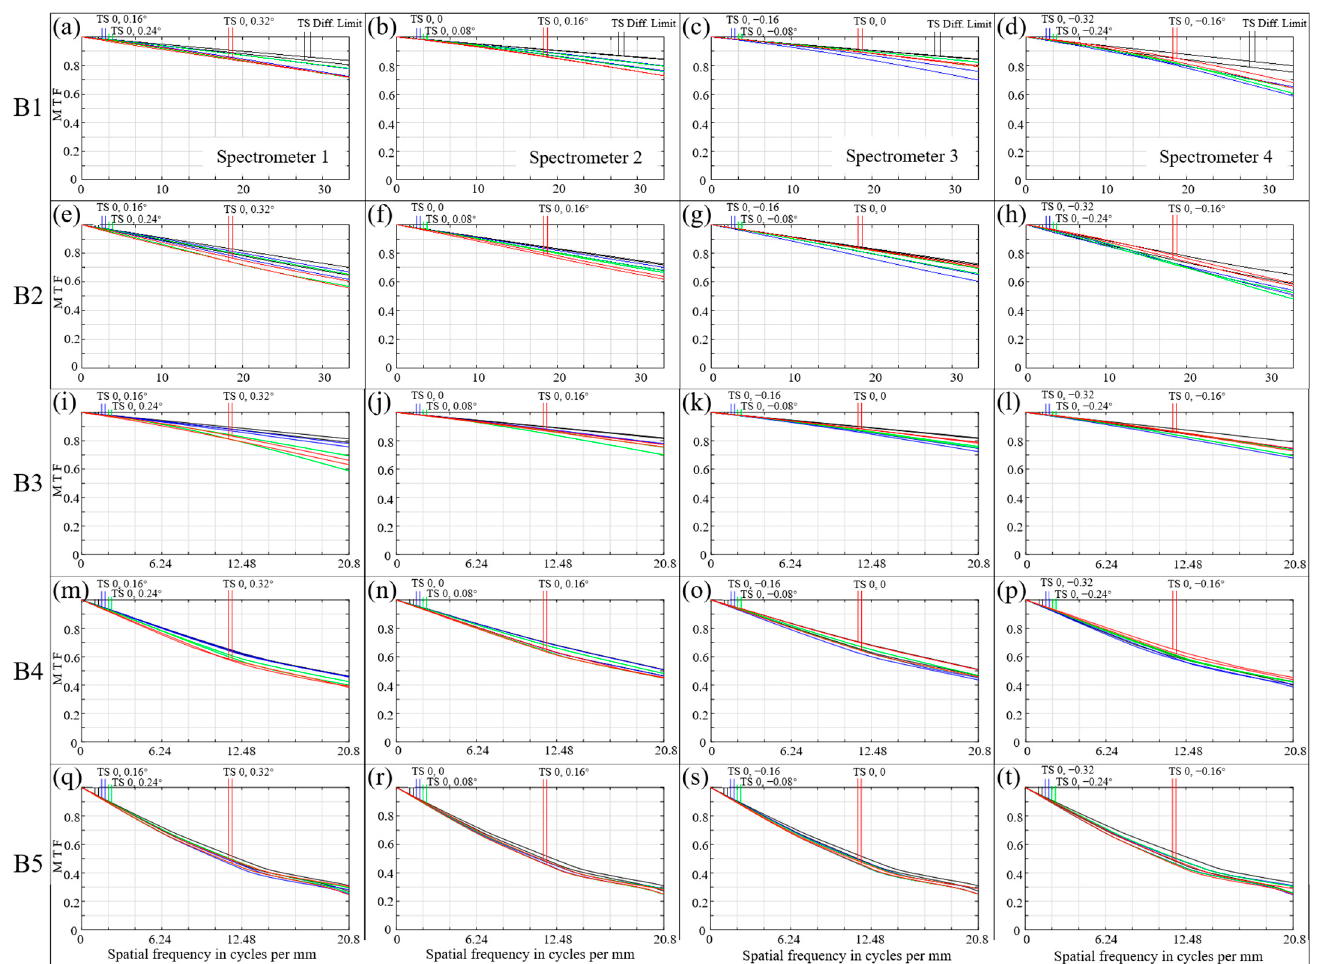
Figure 10. Optical path diagram of GeoFWHIS.